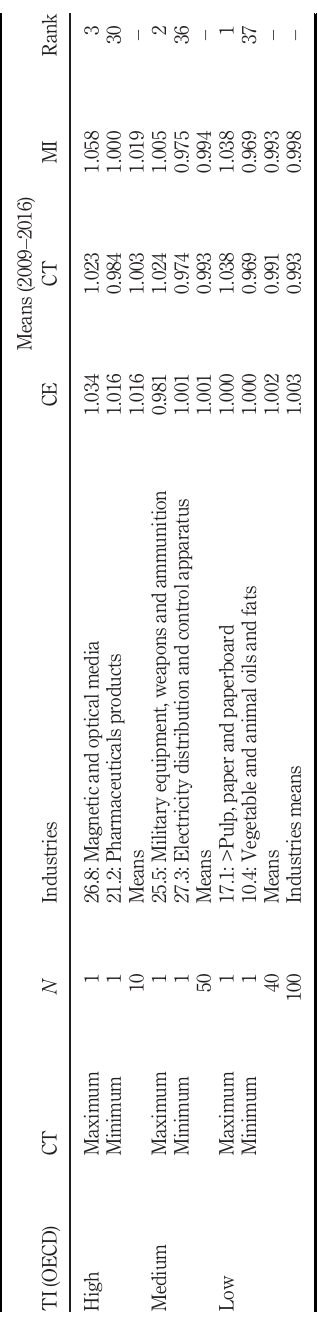
Table 3. Technology intensity (TI), changes in efficiency (CE), changes in technology (CT), Malmquist index (MI) and sectors